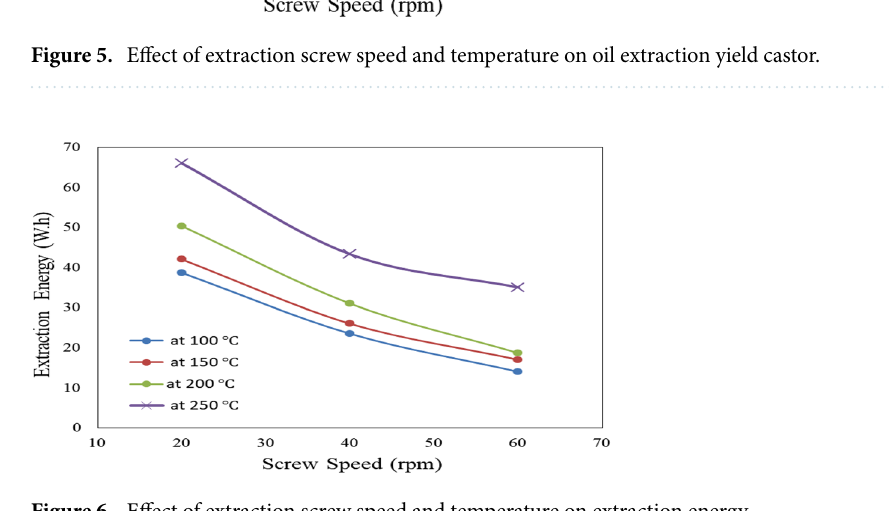
Figure 6. Effect of extraction screw speed and temperature on extraction